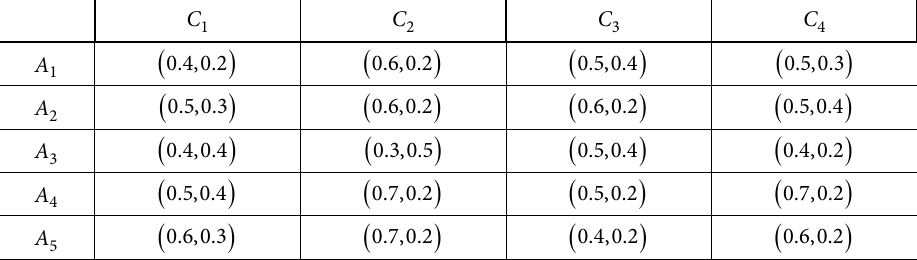
Table 3. Intuitionistic fuzzy decision matrix 3 R  given by 3 D C 1 C 2 C 3 C 4 A